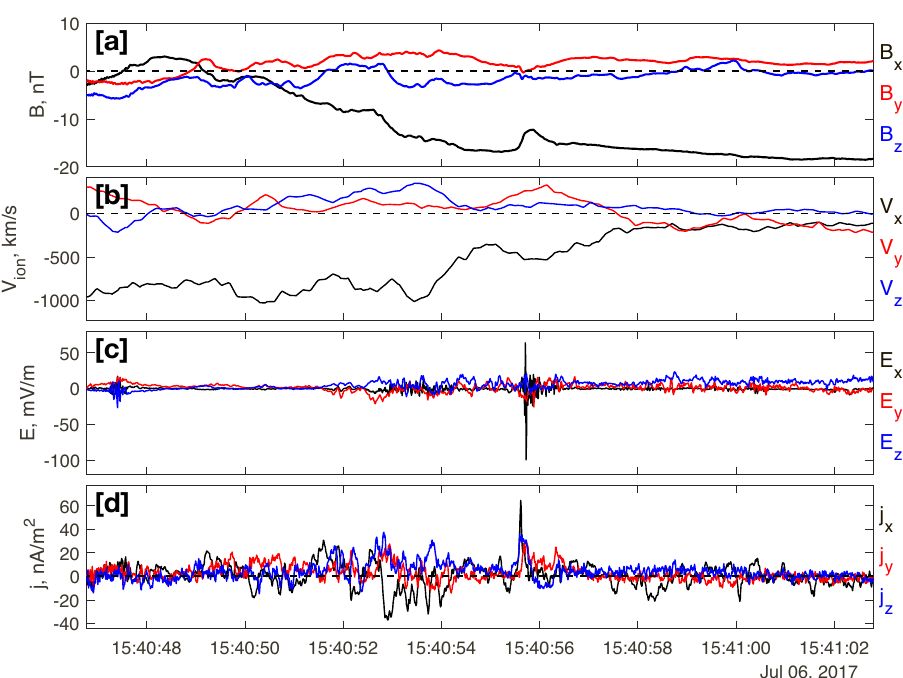
Figure 1. An overview of the MMS observations of FACs on July 6, 2017. From top to bottom: ( a ) three GSE-components of the magnetic field, ( b ) the ion bulk velocity, ( c ) the electric field and ( d ) the electric current density. The observations are shown in the MMS